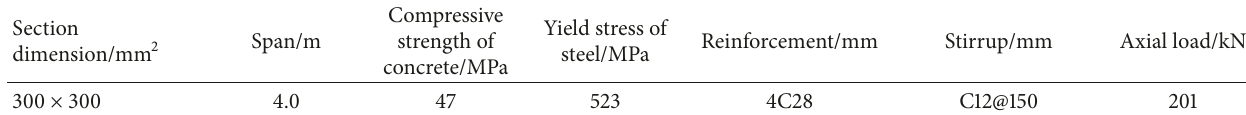
Table 5: Design values of beam specimen [18].